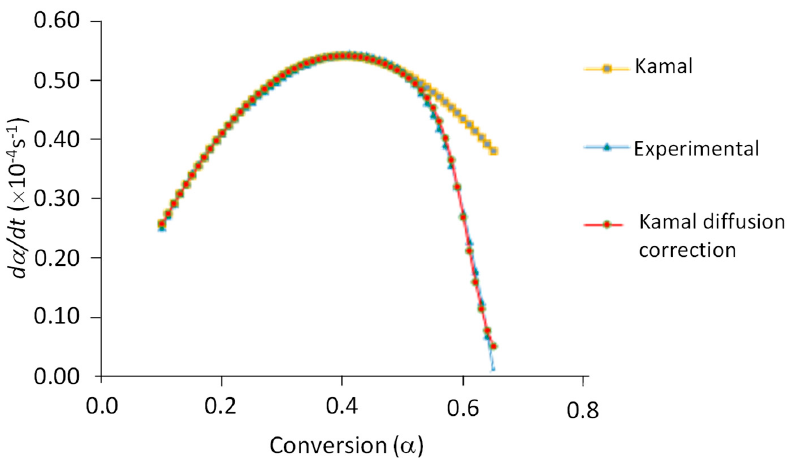
Figure 4. Experimental conversion rate ( d α / dt ) vs. conversion ( α ) at 40 °C of the curing reaction of the composite DGEBA/mXDA/AuNP, 8.5%. Fittings according to Kamal’s model (Equation (2)), with and without diffusion corrections, are also shown.